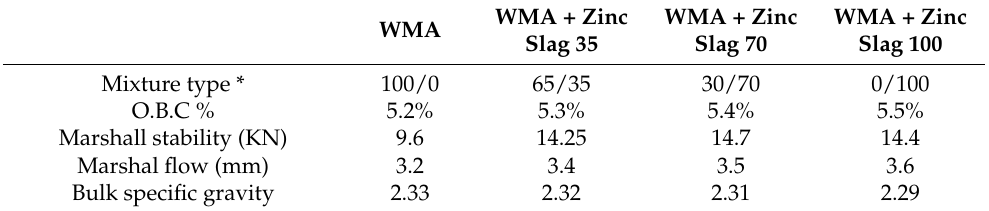
Table 5. Marshall mix design results.